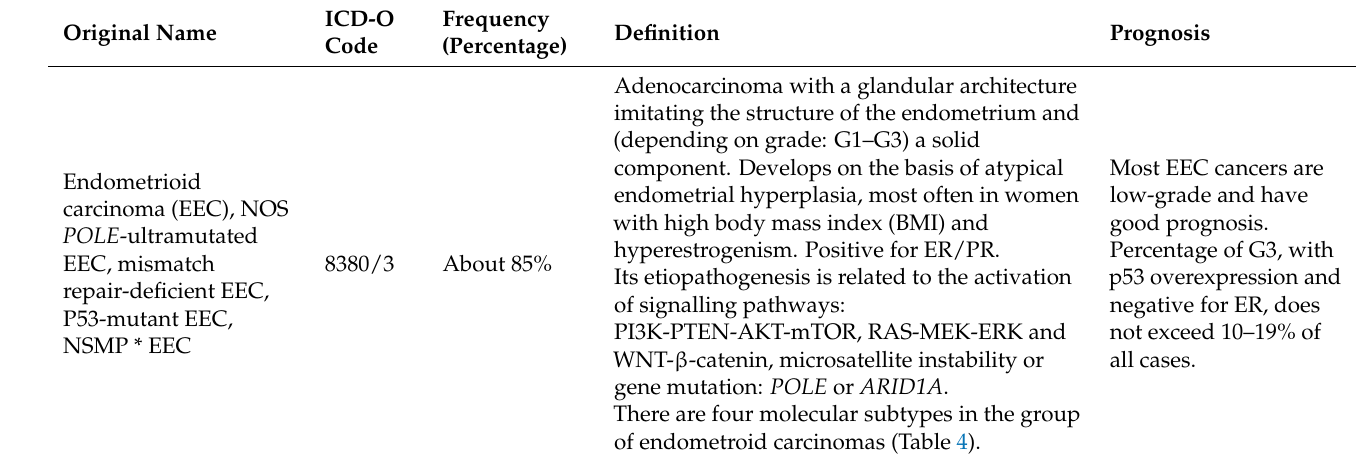
Table 3. Histopathological classification of the carcinoma of the